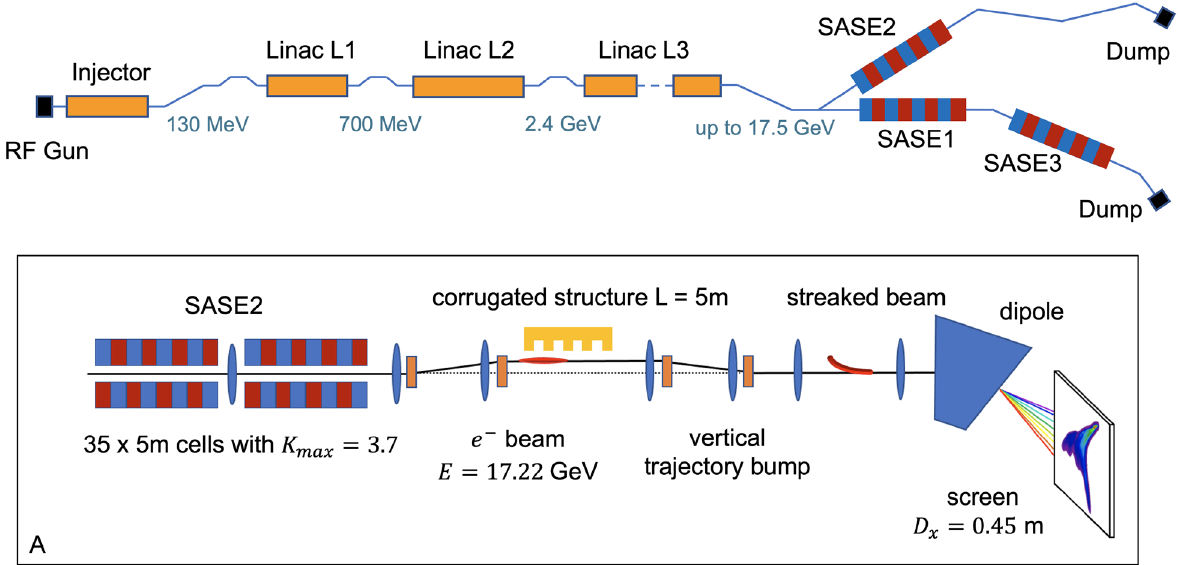
Figure 1. Simplified layout of the European XFEL from photoinjector to the electron beam dumps (not to scale). ( A ) Simplified scheme of the experimental setup for measuring quantum diffusion after the SASE2